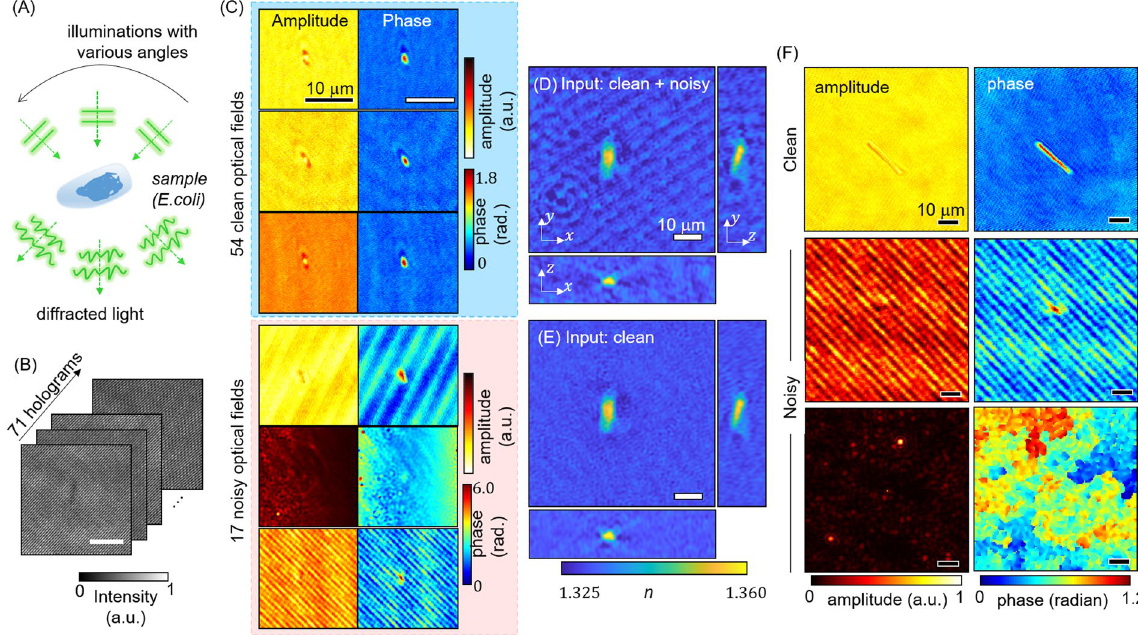
Figure 1. ( A ) In ODT, a sample is illuminated from various angles. ( B ) Holograms obtained under various illumination angles. ( C ) Optical fields reconstructed from the holograms, including 54 clean and 17 noisy fields annotated by a trained ODT user. ( D , E ) RI tomograms of E . coli , recovered using all 71 fields and only the 54 clean fields, respectively. ( F ) Annotation standard. A trained individual has annotated the optical field data to prepare the training and test datasets. (Top) a bacteria cell is visible in the clean background. (Middle) strong unwanted fringe patterns overwhelm the sample, making it hard to identify. (Bottom) the optical fields are totally broken, since unwanted noise was captured in the hologram intensity or no signals were